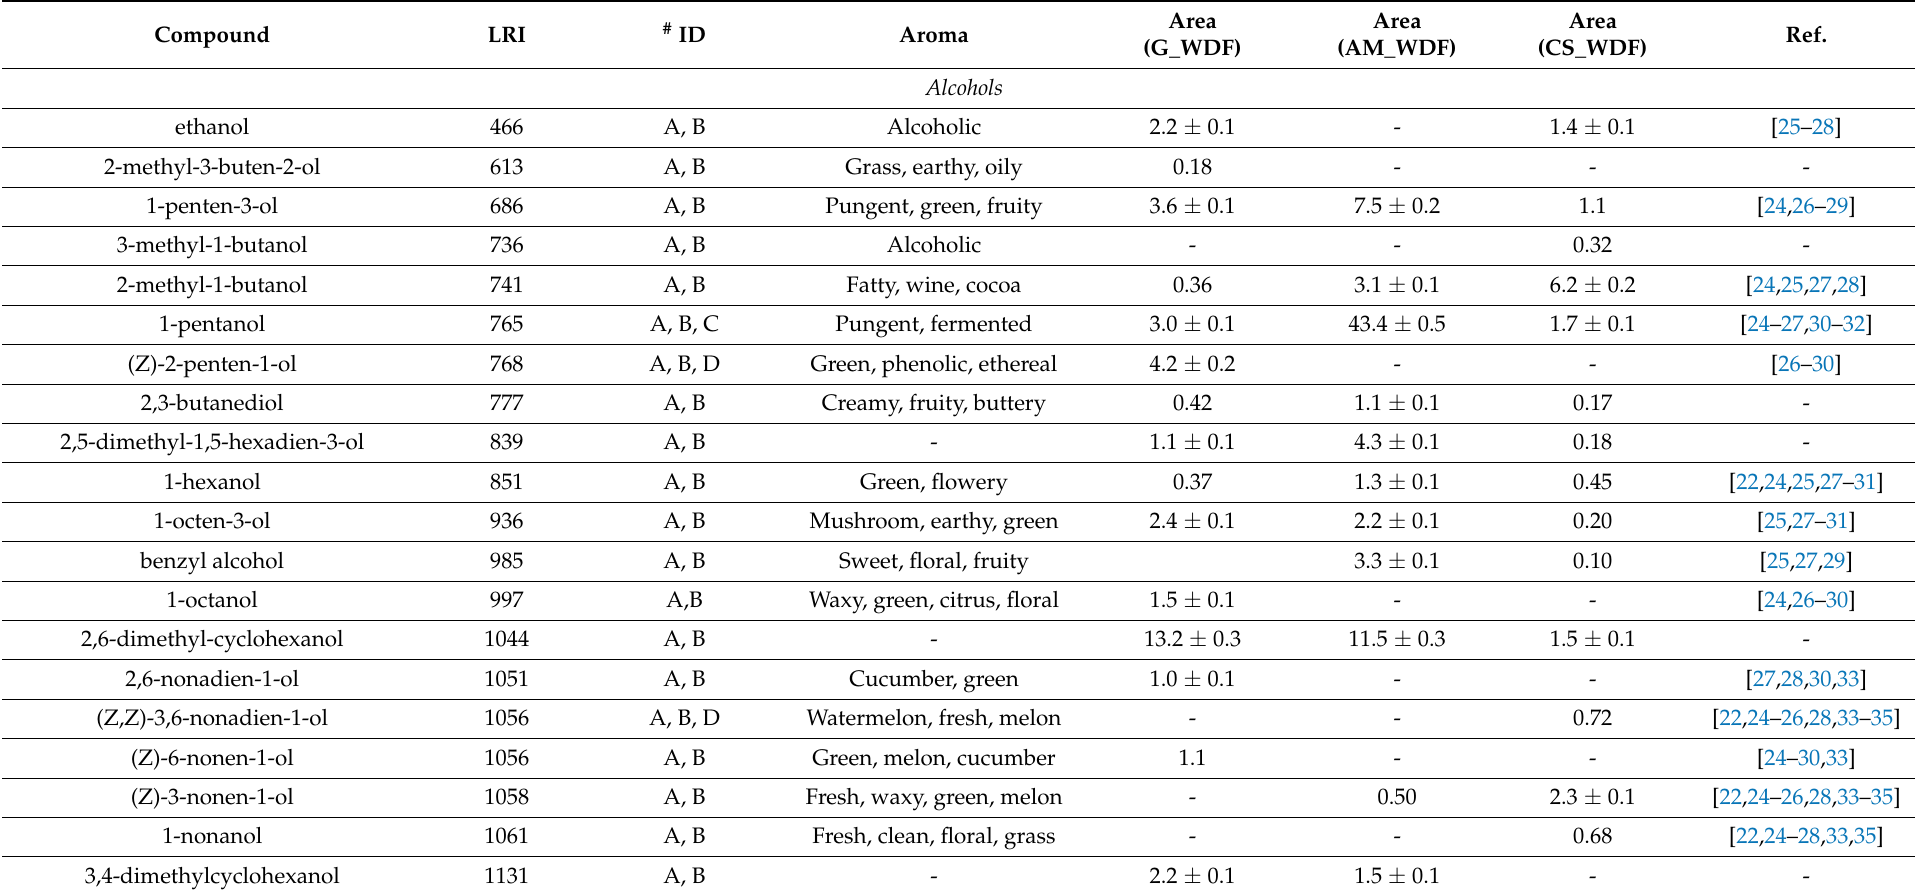
Table 1. VOC composition of vacuum-freeze-dried G_WDF, AM_WDF and CS_WDF identified through HS-SPME-GC-MS analysis, grouped by